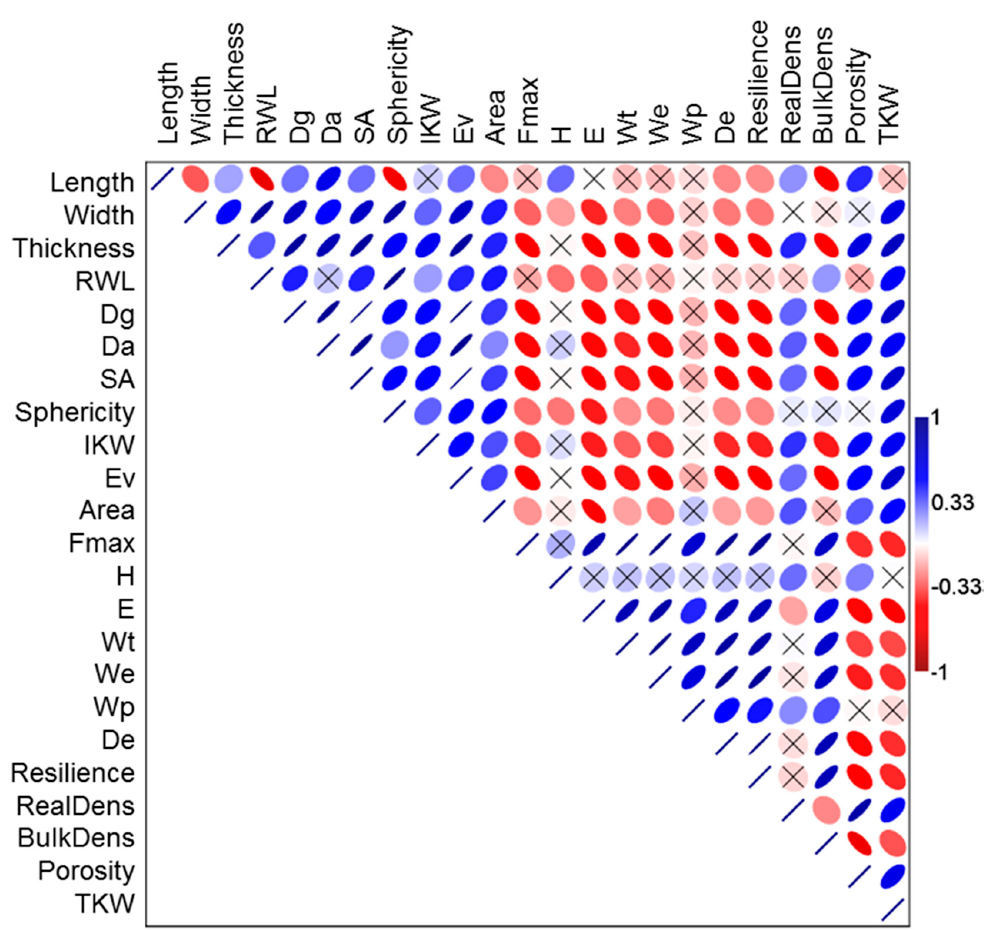
Figure 4. Correlation matrix among the variables of the biophysical and viscoelastic properties of the three cereal types conditioned at two moisture contents (12% and 16%). The crossed ellipses indicate no significant correlation at p > 0.05 (independent of color), and the slope and color define the correlation between each pair of variables (positive or negative).